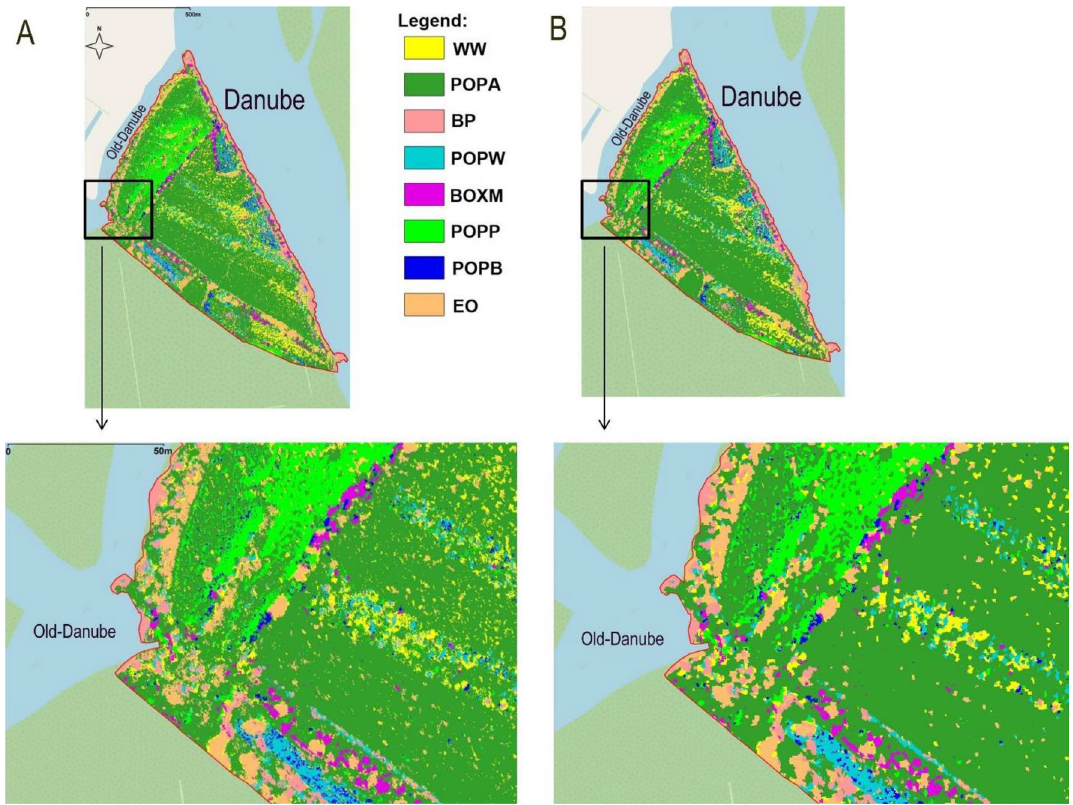
Figure 8. The comparison of pixel-based classification image ( A ) and object-based reclassified classification image ( B ). WW White willow, POPA Poplar (Agathe-F), BP Black pine, POPW White poplar, BOXM Boxelder maple, POPP Pannonia poplar, POPB Black poplar and EO English